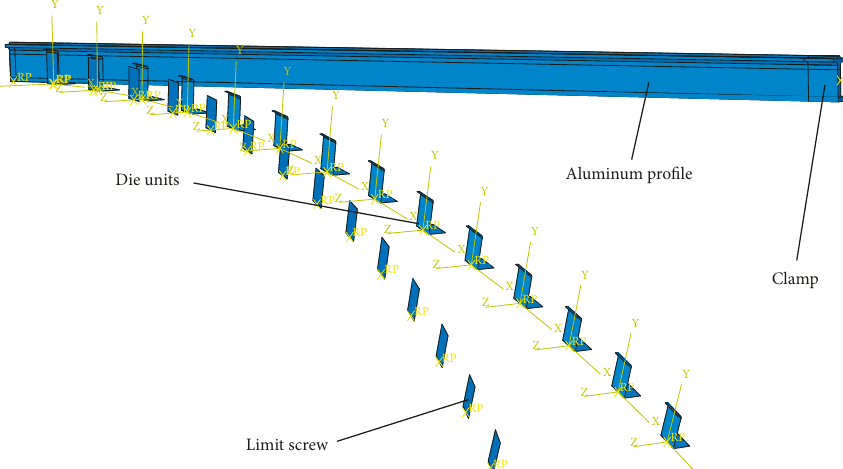
Figure 4: Finite element models for flexible 3D stretch